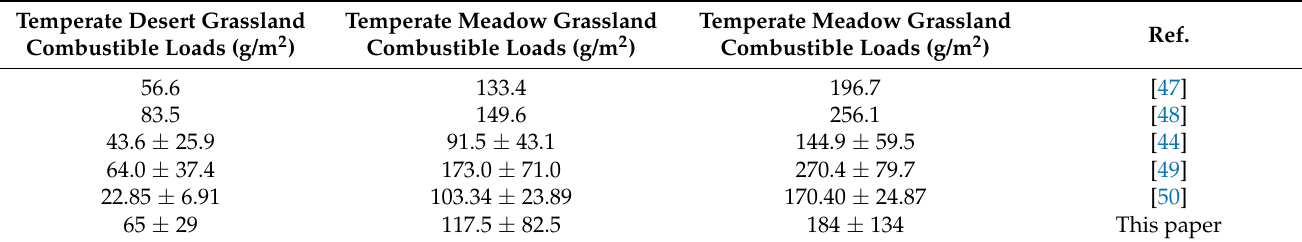
Table 2. Estimated biomass in growing season of grasslands in Inner